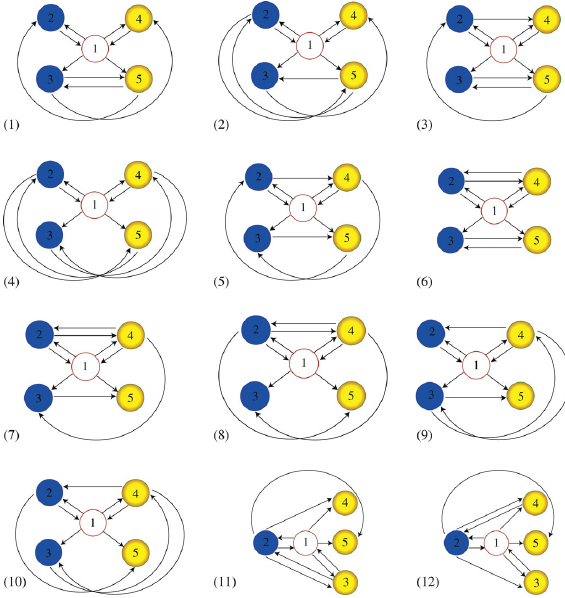
Fig. 11. Quotient of simple fish school model.